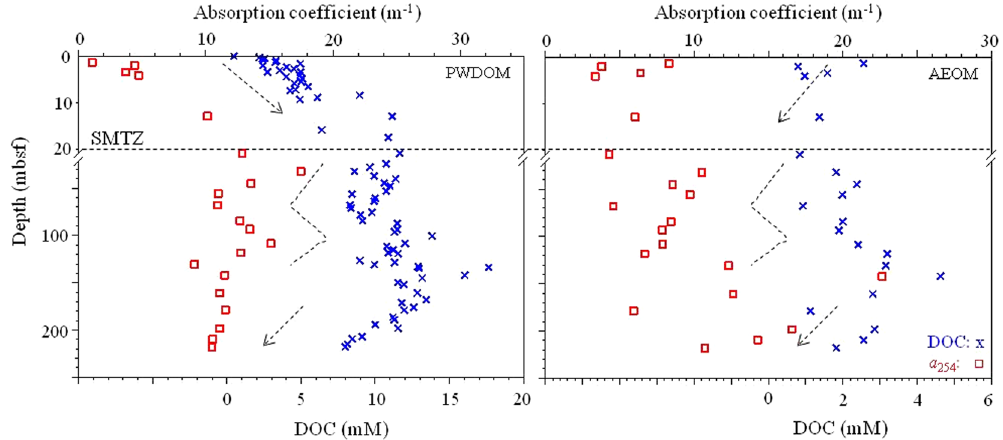
Figure 2. Downcore profile of DOC and CDOM of PWDOM and AEOM at non-chimney site U1. Note the top 21 m showed in amplified